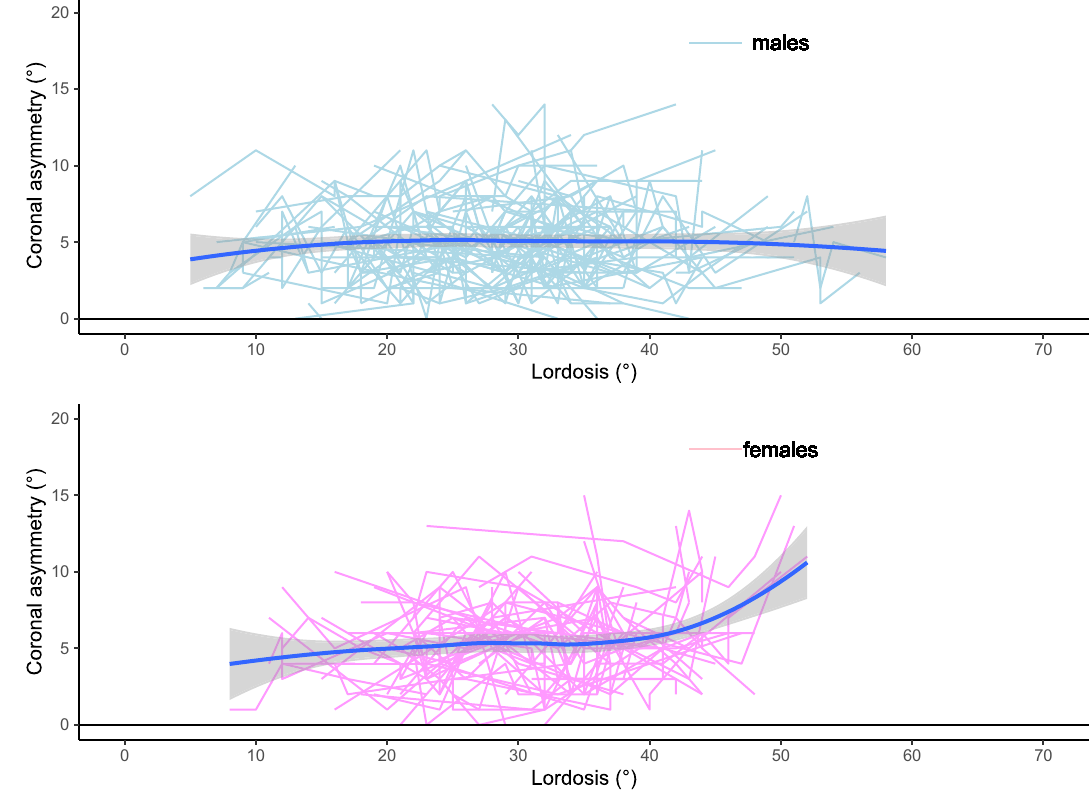
Figure 2. Spaghetti plot of lordosis (°) against coronal asymmetry